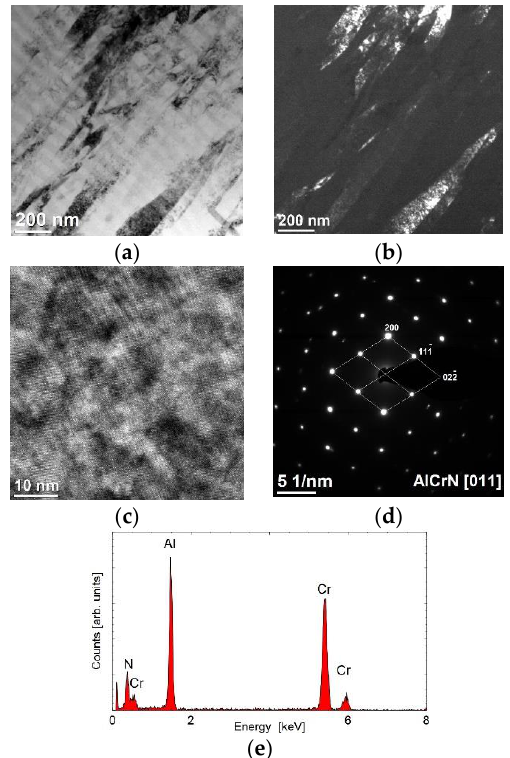
Figure 8. Structure of the AlCrN layer: ( a ) TEM-BF image; ( b ) TEM-DF image based on the reflex (11-1); ( c ) HRTEM micrograph; ( d ) electron diffraction pattern; ( e ) result of the chemical composition analysis. The external layer (Figure 9) with a thickness of approximately 500 nm does not contain